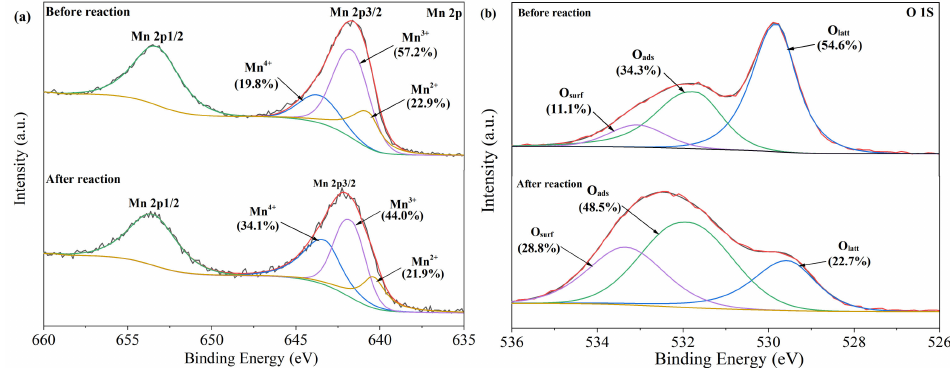
Figure 7. XPS characterization of fresh Mn 2 O 3 and used Mn 2 O 3 : ( a ) Mn 2p, ( b ) O